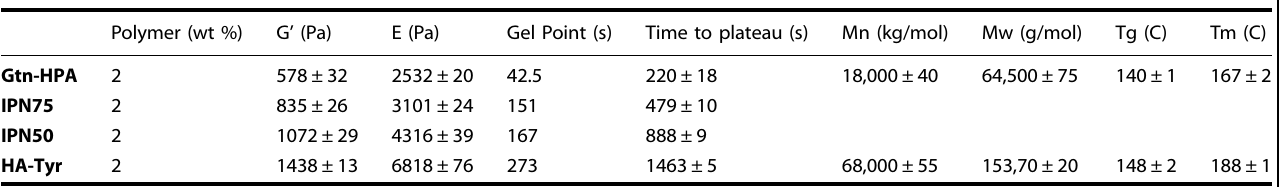
Table 1. Complete characterization of solid polymers and wet